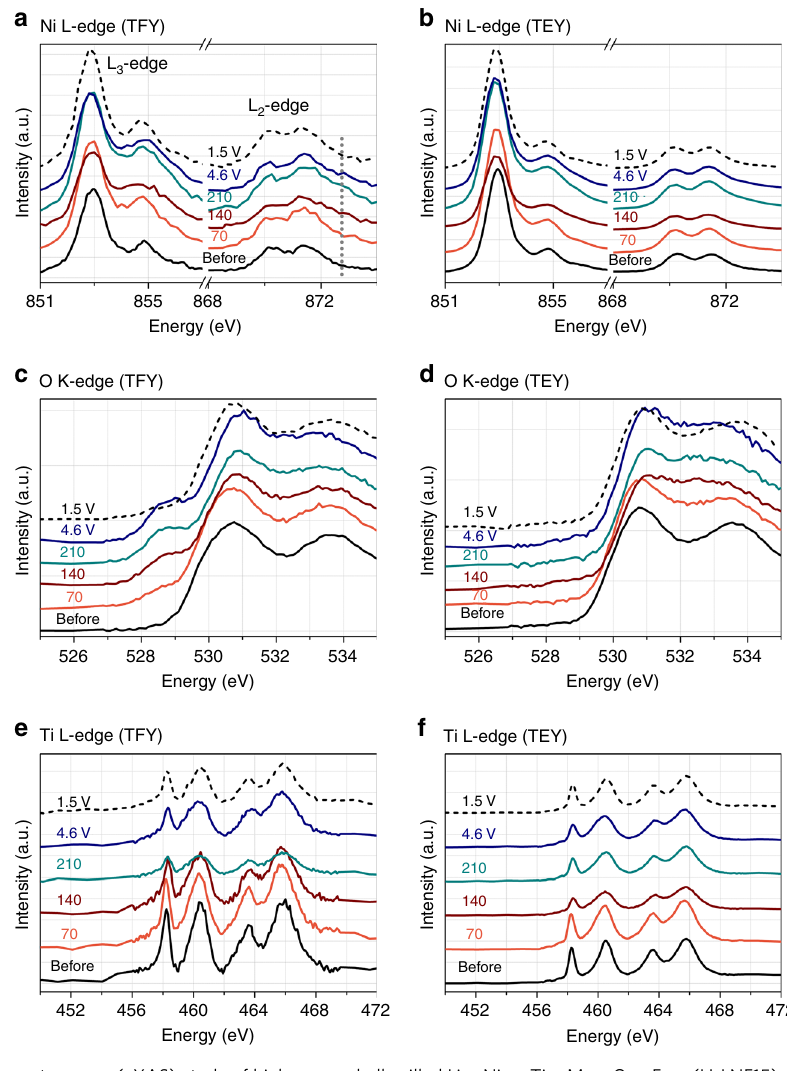
Fig. 8 Soft X-ray absorption spectroscopy (sXAS) study of high-energy ball-milled Li 1.15 Ni 0.45 Ti 0.3 Mo 0.1 O 1.85 F 0.15 (H-LNF15). sXAS spectra at the Ni L-edge: a bulk-sensitive total fl uorescence yield (TFY) mode, b surface-sensitive total electron yield (TEY) mode. sXAS spectra at the O K-edge: c TFY mode, d TEY mode. sXAS spectra at the Ti L-edge: e TFY mode, f TEY mode. The data was collected before cycling H-LNF15 (black), after charging to 70 mAh g – 1 (orange), 140 mAh g – 1 (dark red), 210 mAh g – 1 (turquoise), 4.6 V (~ 280 mAh g – 1 , dark blue), and after discharging to 1.5 V (black dash). H-LNF15 cells were cycled at 20 mA g – 1 at room